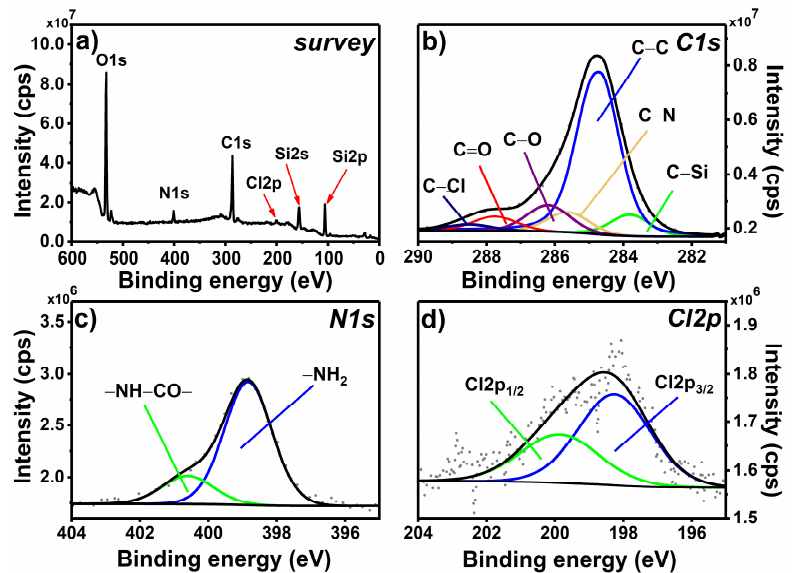
Figure 2. XPS survey spectrum ( a ) and high-resolution spectra of C1s ( b ), N1s ( c ), and Cl2p ( d ) regions registered for the TC_APTES@glass monolayer.